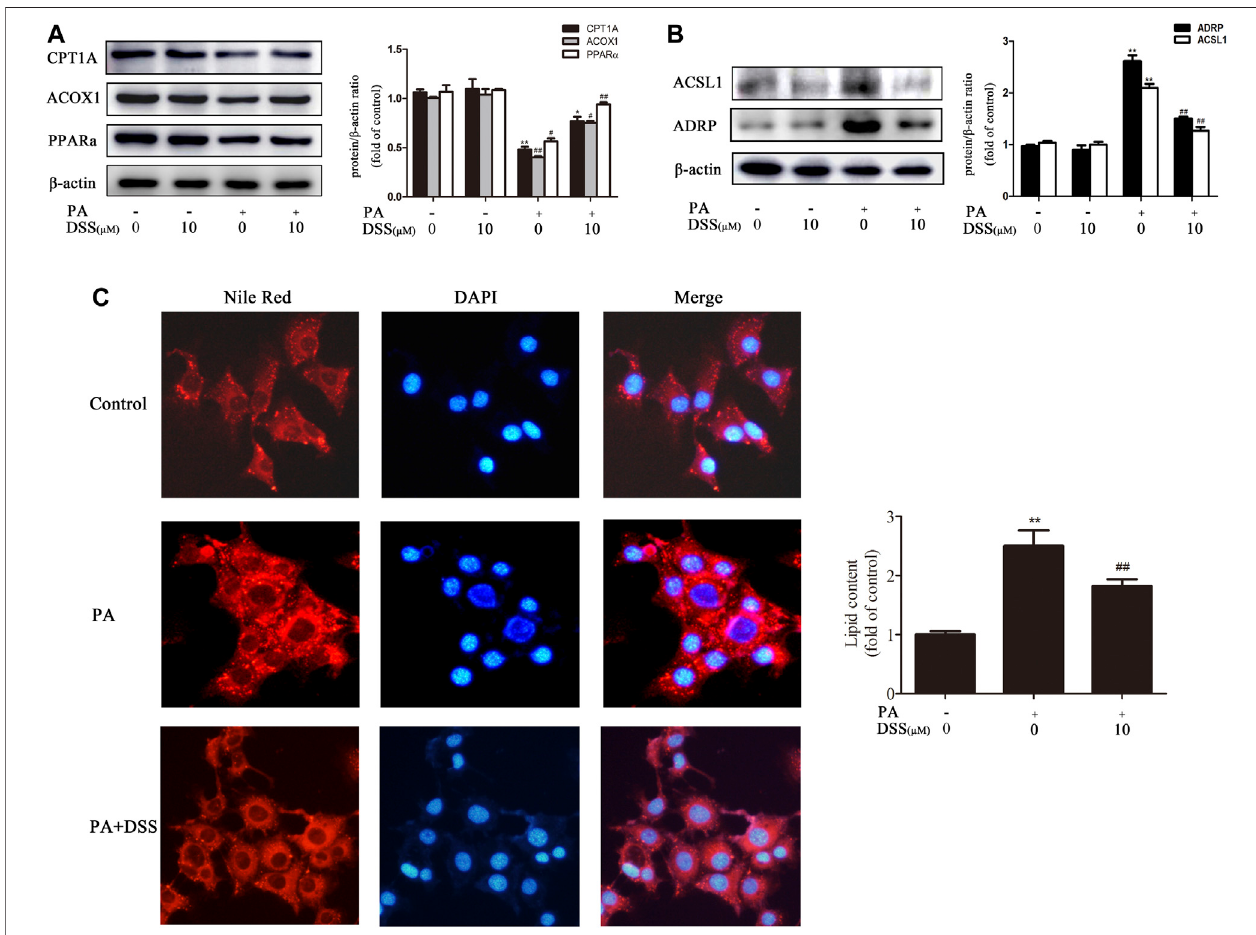
FIGURE3| DSSpromotesfatty acid β -oxidation andreducesLDaccumulation invitro . AML-12cells werepretreated withDSS(10 μ M) for6 hbefore exposure to PA (0.4 mM) for another 24 h (A,B) Western blot analysis of fatty acid β -oxidation-related genes (CPT1A, ACOX1 and PPAR α ) and LD accumulation-related genes (ACSL1 and ADRP) protein levels in the cell lysates ( n (cid:2) 3). (C) Intracellular lipid accumulation was measured by Nile red staining (200 × ). * p < 0.05, ** p < 0.01 vs. the control group; # p < 0.05, ## p < 0.01 vs. the PA group.